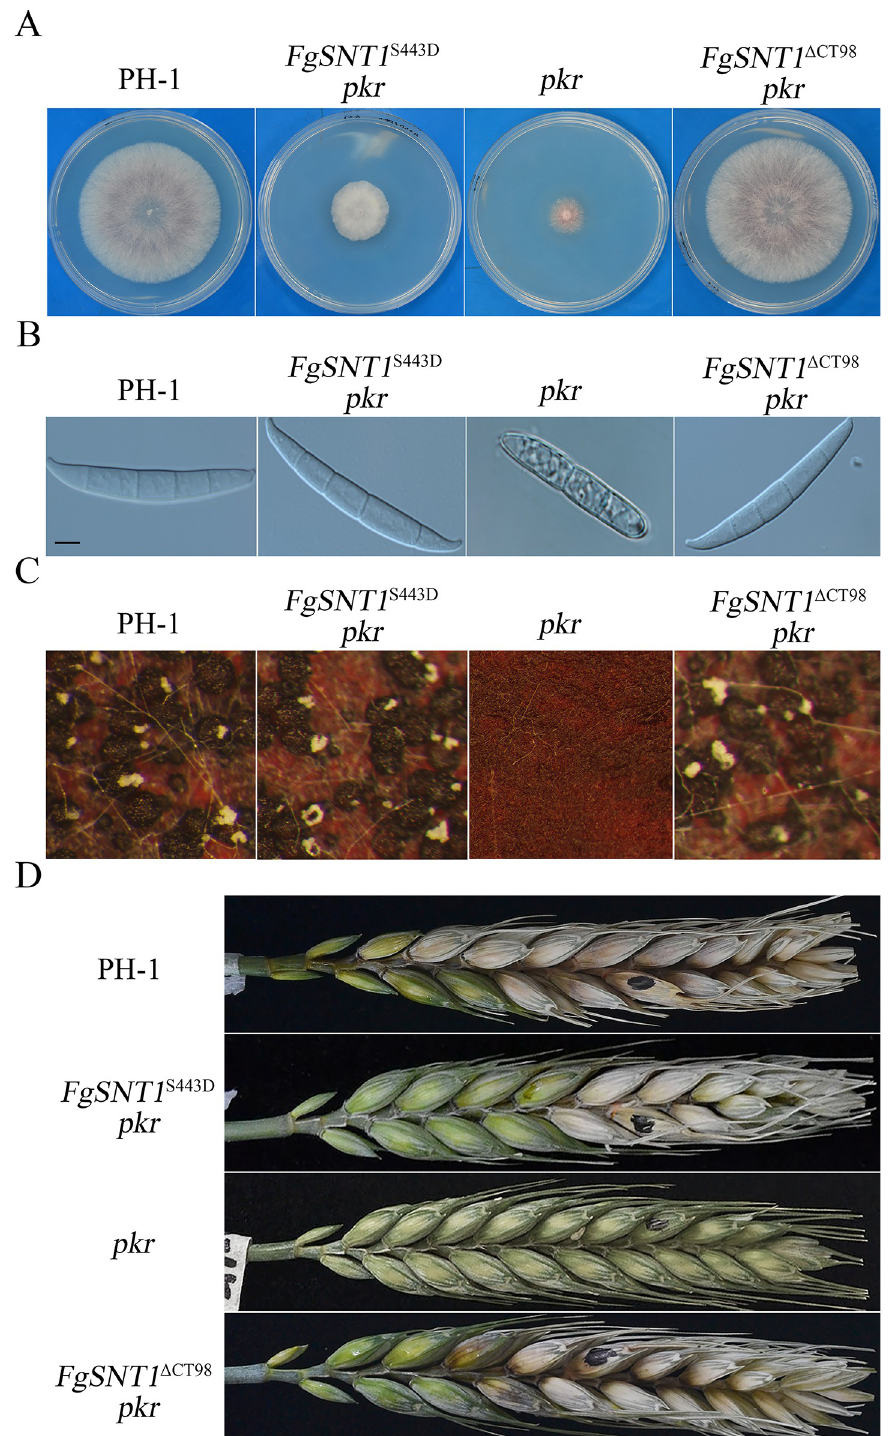
Fig 9. The S443D mutation in FgSNT1 partially rescues defects of the pkr mutant. (A). Three-day-old PDA cultures of PH-1 and the FgSNT1 S443D pkr , FgSNT1 Δ CT98 pkr and pkr mutants. (B). Conidia of the same set of strains from 5-day-old CMC culture. Bar = 10 μ m. (C). Perithecia from mating cultures of the marked strains were examined at 12 dpf. (D). Wheat heads inoculated were examined for head blight symptoms at 14 dpi. Black dots mark the inoculated